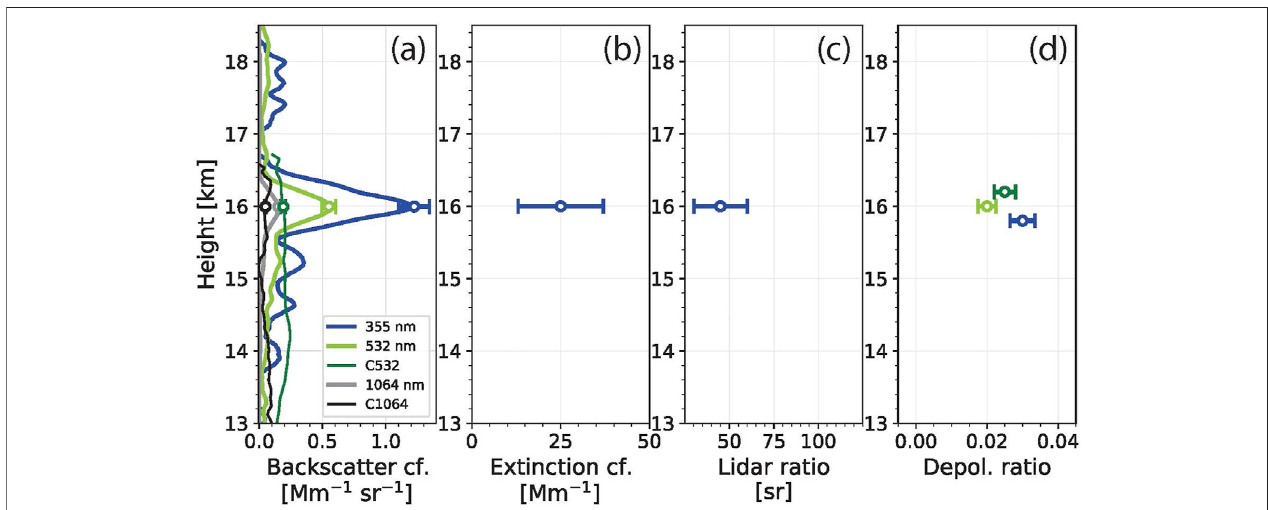
FIGURE 4 | Optical properties of stratospheric sulfate particles measured with the Polly lidar at Leipzig on July 22 – 23, 2019, 22:45 – 00:15 UTC: (A) 1.5-h mean heightpro fi lesoftheparticlebackscattercoef fi cient atthree wavelengths, (B) respectivelayer-mean355 nm particle extinction coef fi cient fortheshallowlayerfrom 15.5 to 16.5 km height, (C) layer-mean 355 nm lidar ratio, and (D) layer-mean particle linear depolarization ratio at 355 and 532 nm. Error bars (one standard deviation) indicate the estimated uncertainties in the observations. For comparison, mean particle backscatter coef fi cients (in a, C1064, C532, thin lines) and layer-mean particle depolarization ratio (in d, dark green circle) measured with CALIOP in the latitudinal band from 45 – 54 ° N ( Figure 2 ) are shown in addition. To better see the different layer mean depolarization ratio values (all belong to 16 km height) we shifetd two of them to 15.8 and 16.2 km.